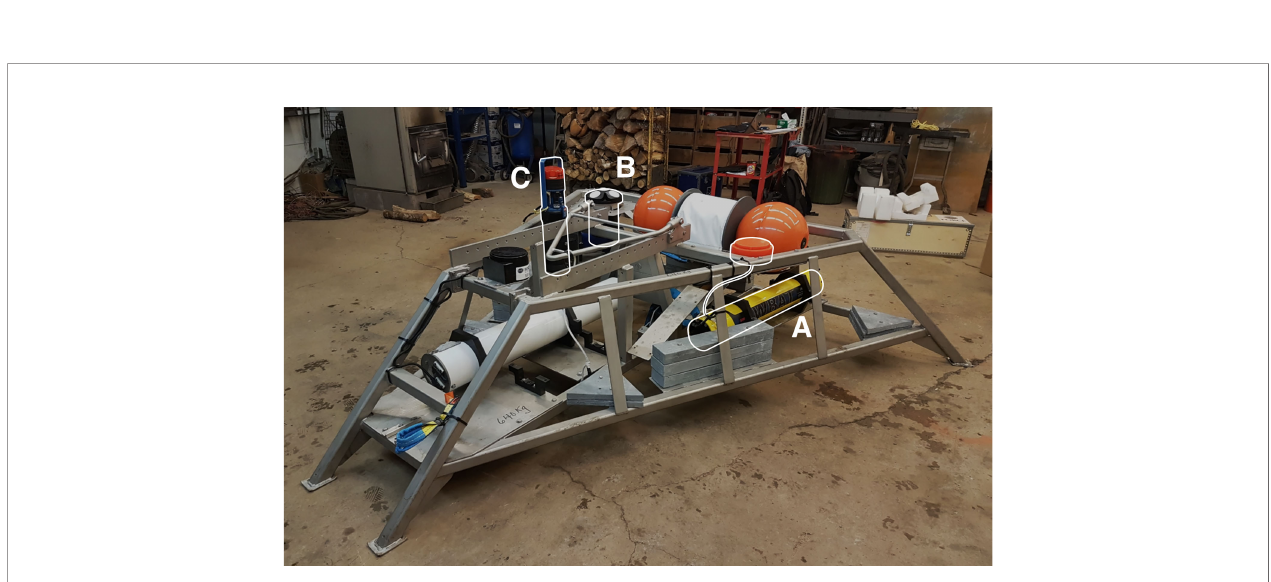
FIGURE 2 | FAST-3 platform deployed at the FORCE Tidal energy test site from 30 Mar to 23 May 2018. Equipment included (A) Simrad WBAT EK80 echosounder, (B) Nortek Signature 500 ADCP, (C) Aanderaa SeaGuard